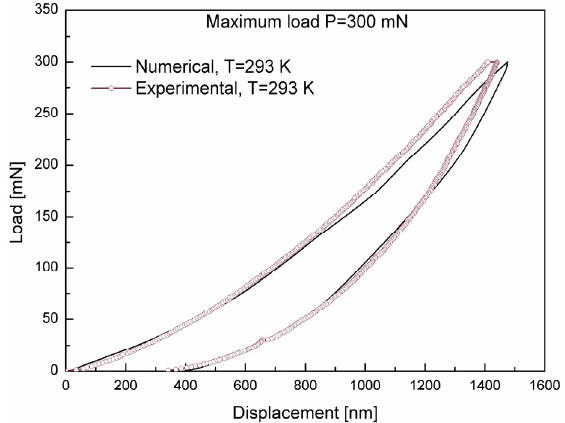
Figure 6: Comparison of the Load-Displacement curves obtained from FE simulations and experimentally measured (T=293 K, P=300 mN).